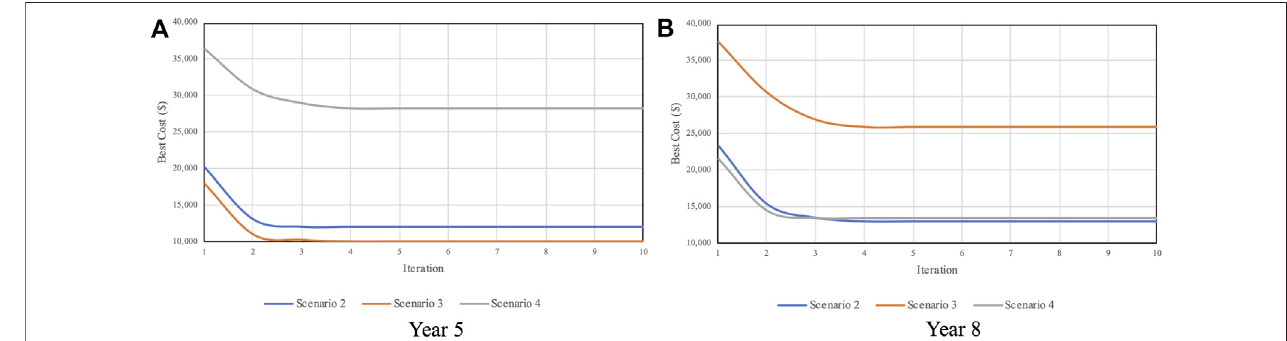
FIGURE 10 | PSO convergence for the best total cost in Years 5 and 8.